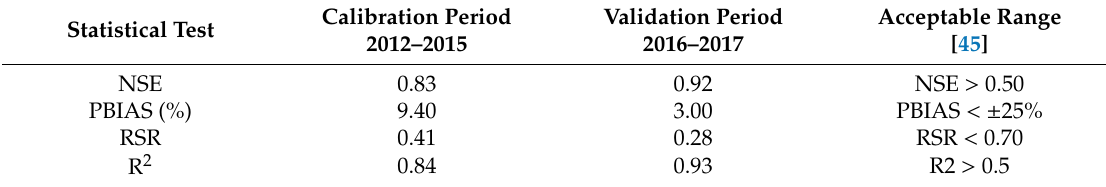
Figure 6. Monthly comparison of simulated and observed streamflow data for the calibration (2012–2015) and validation (2016–2017) periods along with precipitation data for the entire range (cms: m 3 /s). Table 3. Statistical Evaluation of the calibration & validation of the Blue River Watershed.